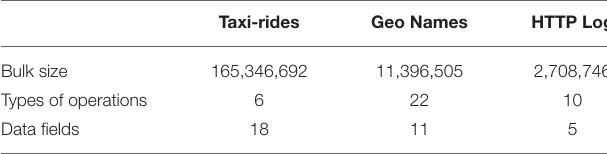
TABLE 4 | Meta-data for the three sets of